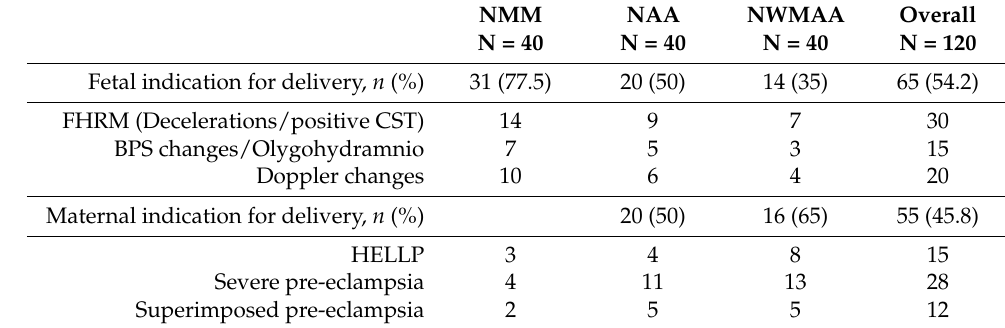
Table 2. Indications for